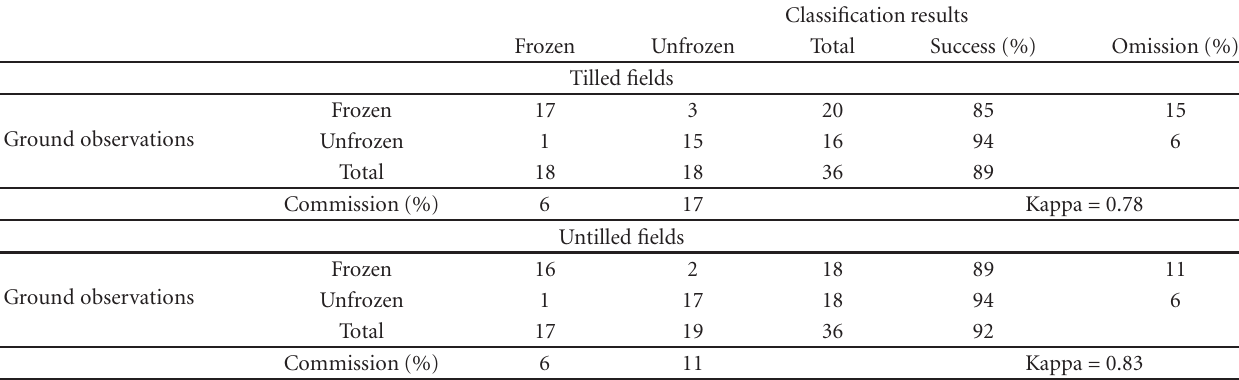
Table 5: Classification results of six selected RADARSAT-1 SAR images compared with soil temperature measurements at the 12 training/validation study fields, by land